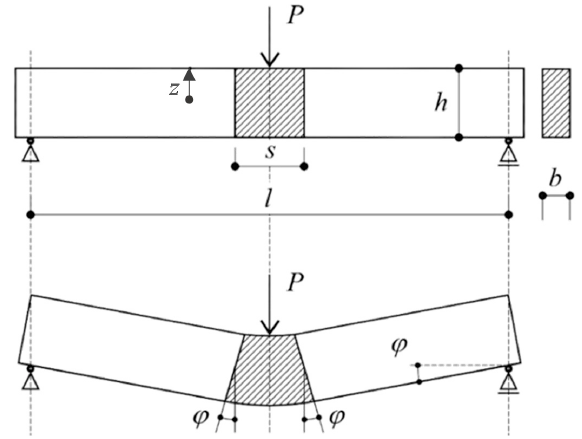
Figure 3. Kinematics of the Cracked-Hinge Model.